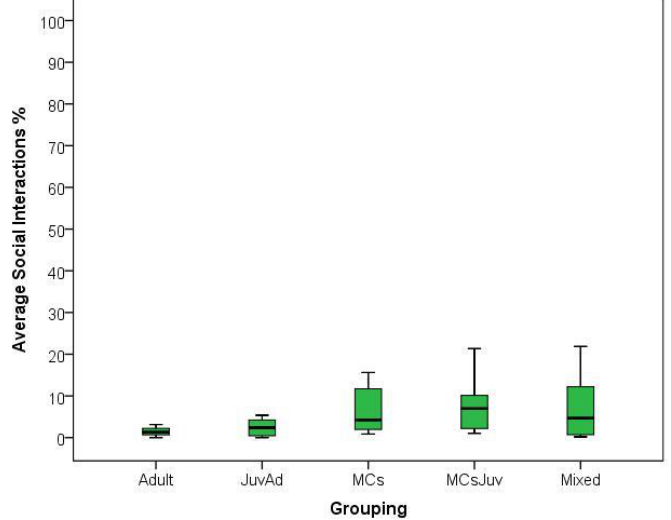
Figure 3. Boxplots of average social interactions percentage per social grouping. Note the scale is a